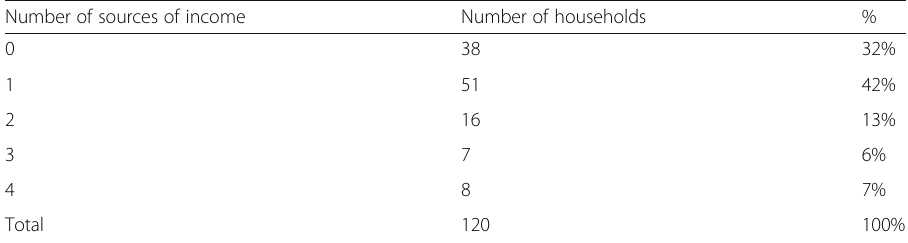
Table 3 Households and non-agricultural sources of income Number of sources of